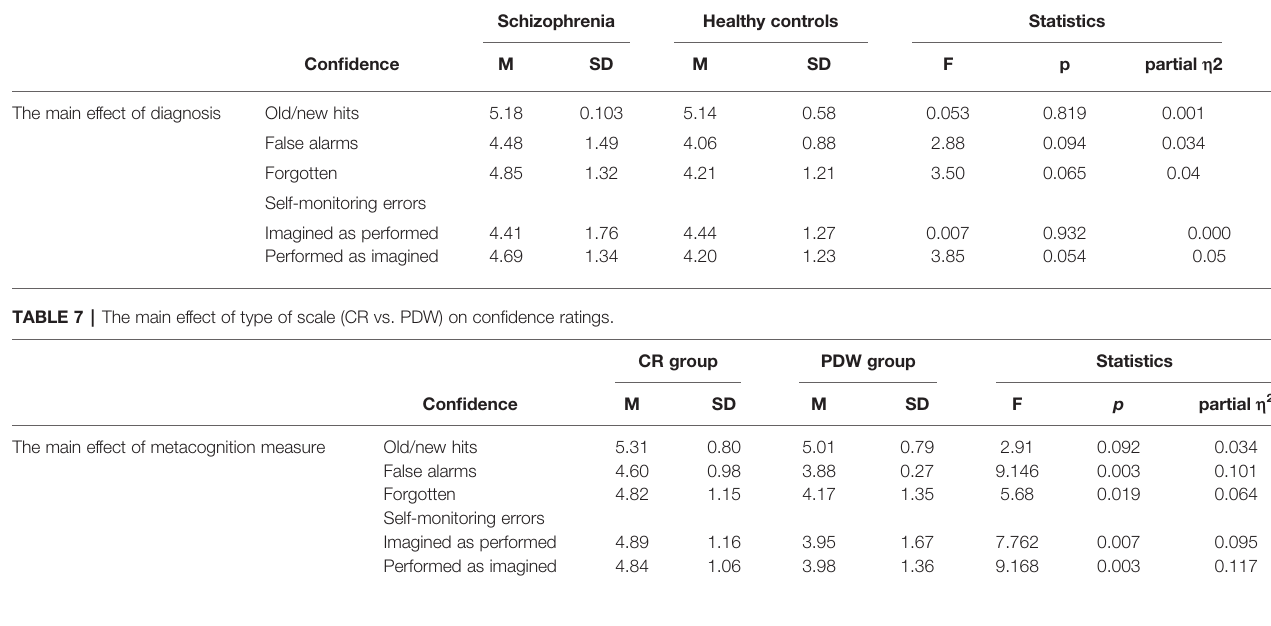
TABLE 6 | The main effect of diagnosis (patients ’ group vs. healthy controls) on con fi dence ratings.